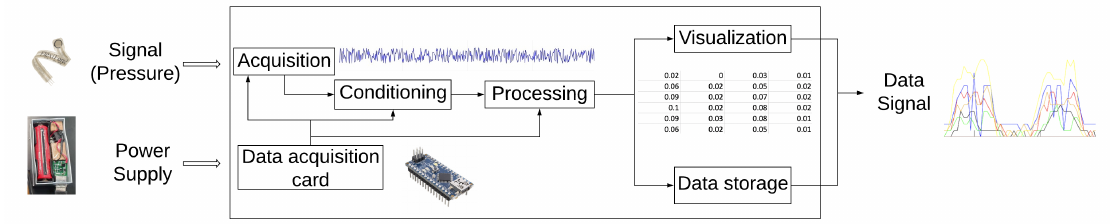
Figure 5. Resistive sensor FlexiForce A201 ® connection diagram, where node 1 refers to input voltage, and node 2 refers to ground and node 3 refers to output voltage.